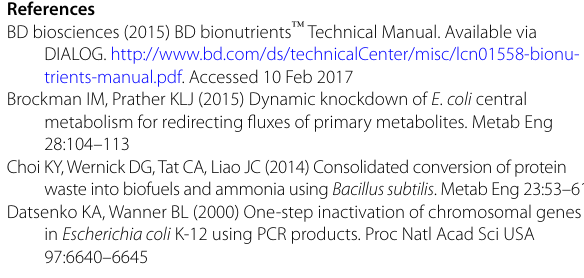
The values were calculated based on the nitrogen contents of BD Bionutrients ™ Technical Manual Third edition (http://www.bd.com/ds/technicalCenter/misc/ lcn01558-bionutrients-manual.pdf). Total amino acids include forms of protein and peptide